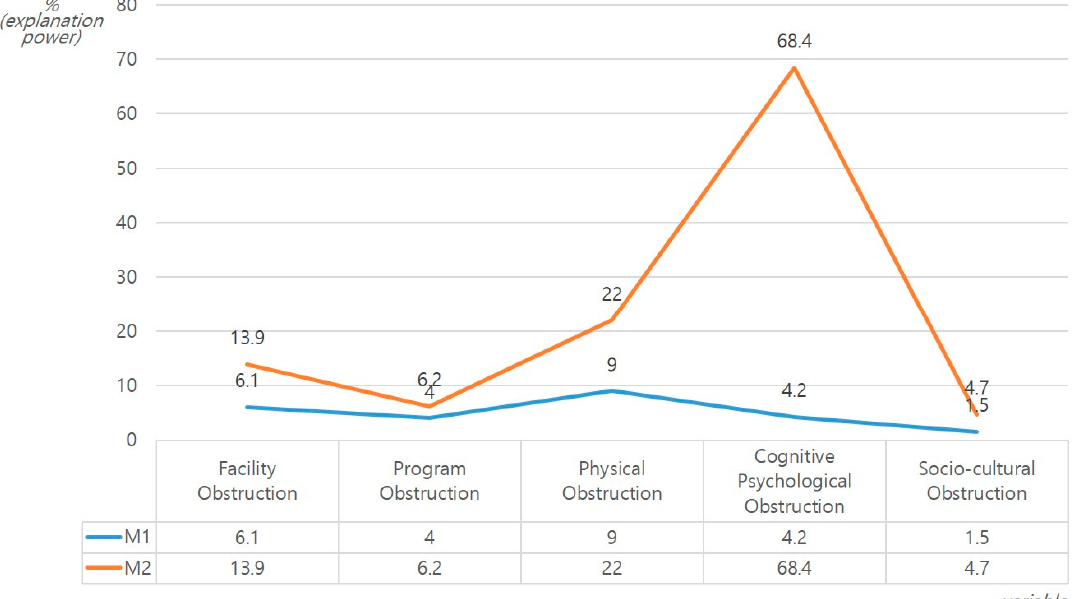
Figure 4. Results of the hierarchical regression analysis for the effects of the physical activity levels and obstruction factors based on the physical activity participation experience (NE).